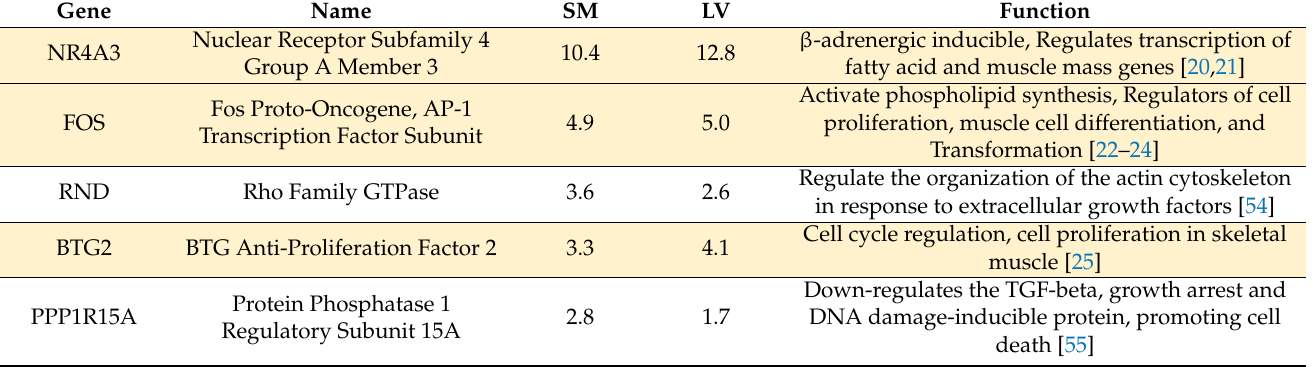
Table 1. Genes differentially expressed in cardiac and skeletal muscle of GGF2-treated post-MI